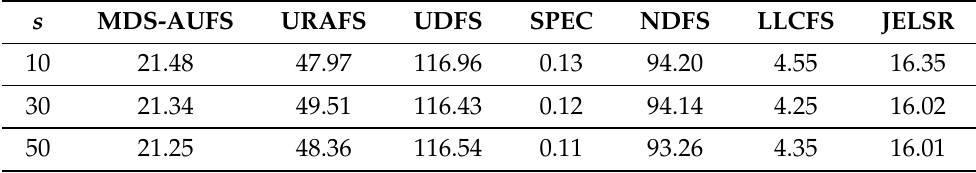
Table 5. The computation time of different methods on the lung dataset (unit: second).